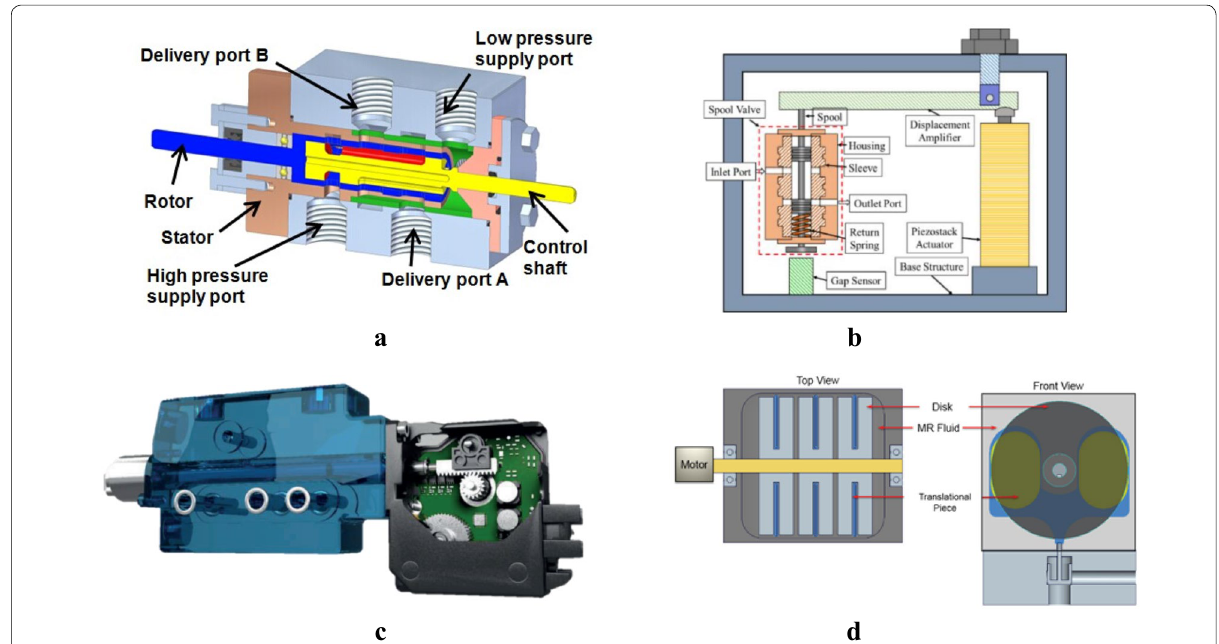
Figure 7 ( a ) Schematic of the rotary valve; ( b ) Schematic of the piezoelectric actuator valves; ( c ) Electromechanical valve actuator; ( d ) Stacked valve configuration of the electronic control valve (ECV)